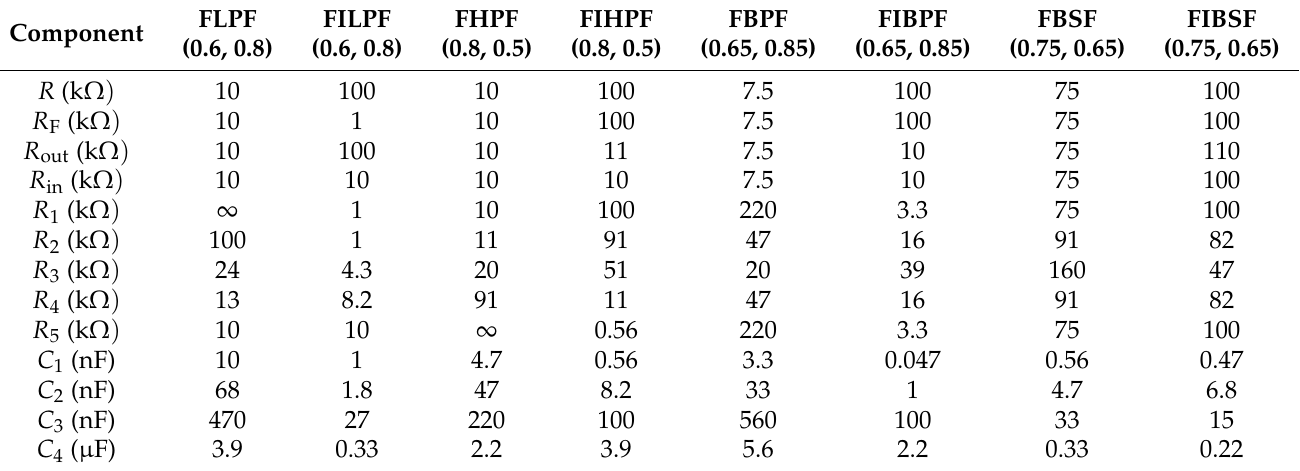
Table 12. Values of components to realize the proposed filters. [Note: Numbers in parenthesis represent ( α , β ) ].